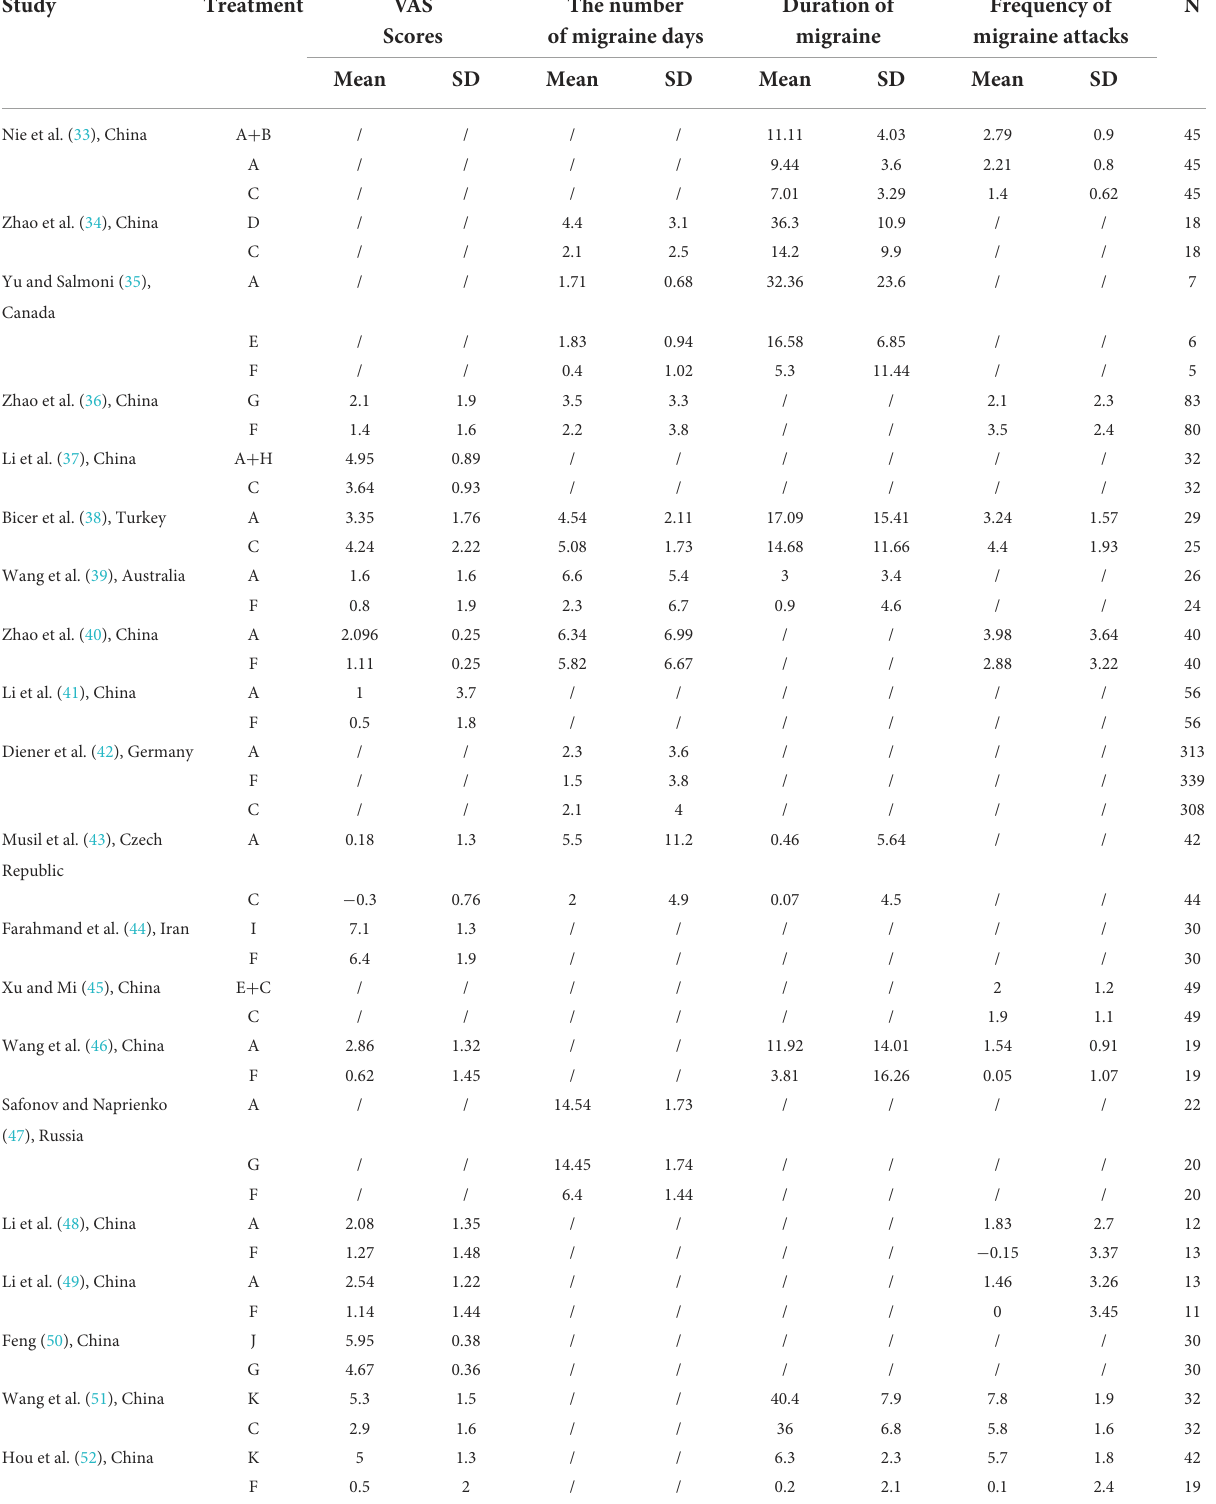
TABLE 3 Summarize of mean, standard difference, and sample size between treatment groups for included studies in a network